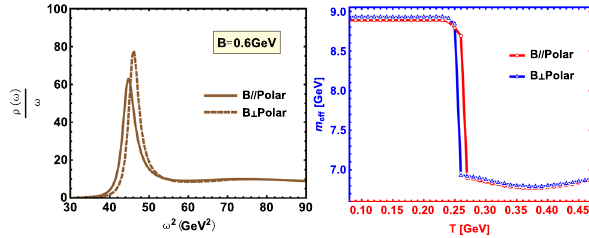
Fig. 12 Left: The spectral function of the ϒ( 1 S ) state for parallel case and perpendicular case at T = 0 . 3GeV ,μ = 0 . 6GeV. Right: The effective mass of the ϒ( 1 S ) state for parallel case and perpendicular case at B = 0 . 3GeV ,μ =